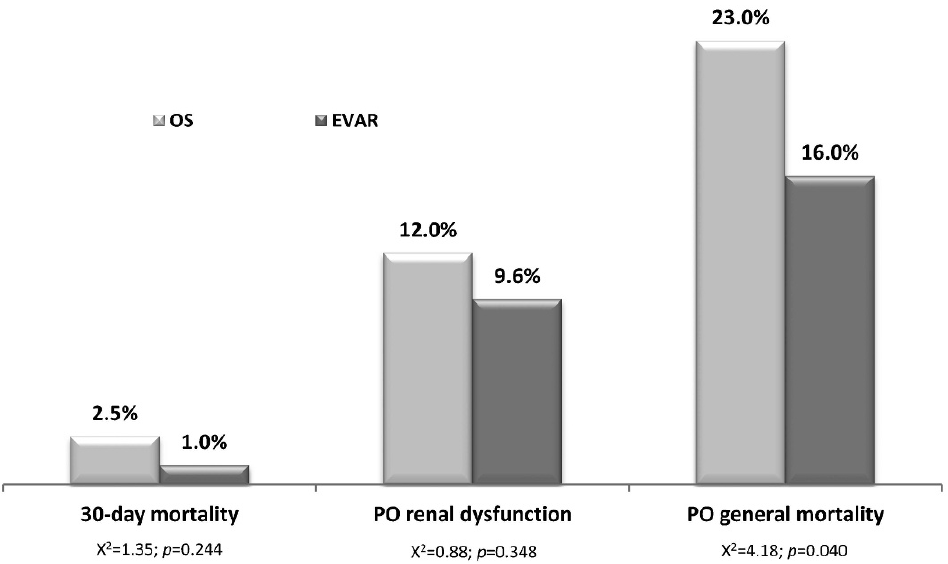
Figure 3 - Distribution of the patients treated with OS (in five studies) and EVAR (in four studies) according to 30-day mortality, PO renal dysfunction and PO general mortality rates.